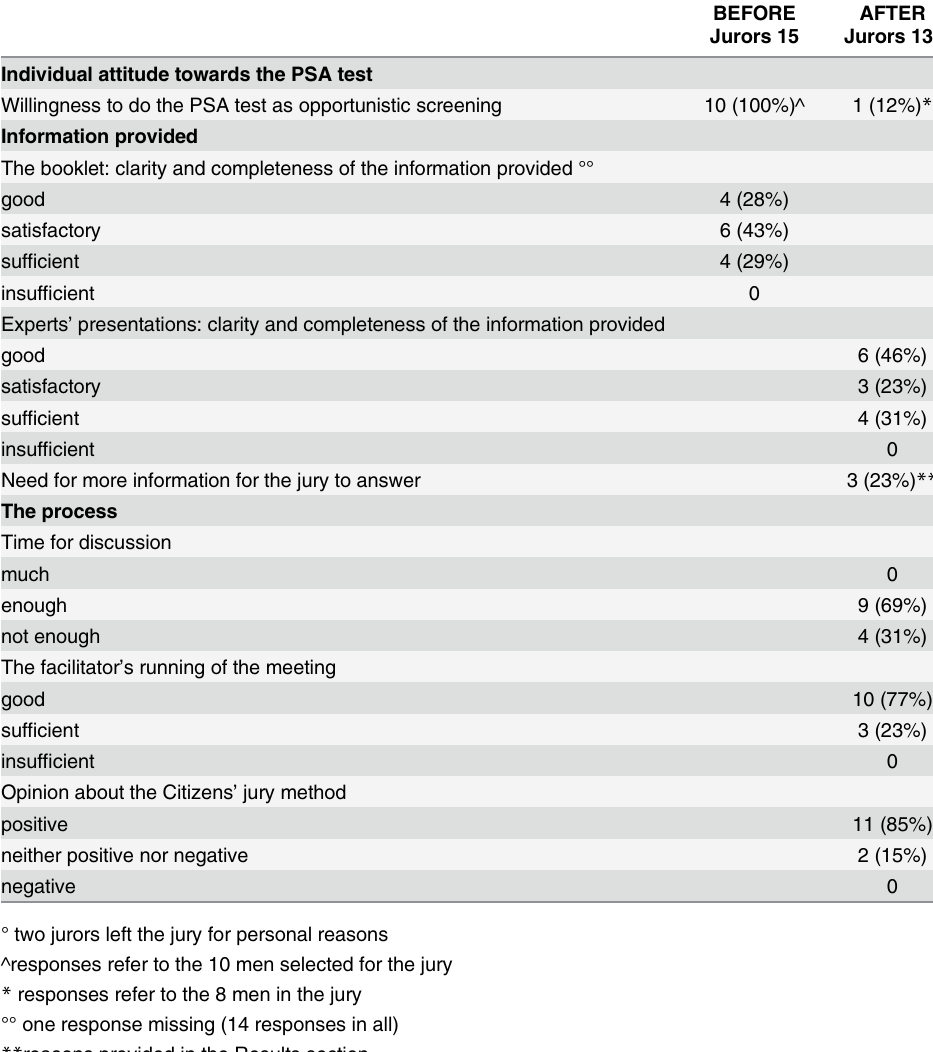
Table 1. Questionnaires submitted before and after the jury met.